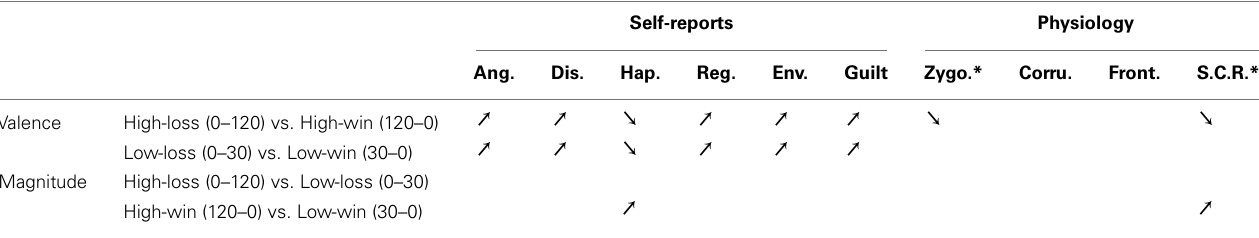
Table 1 | Summary of statistical results for the effect of outcomes in the no-conflict